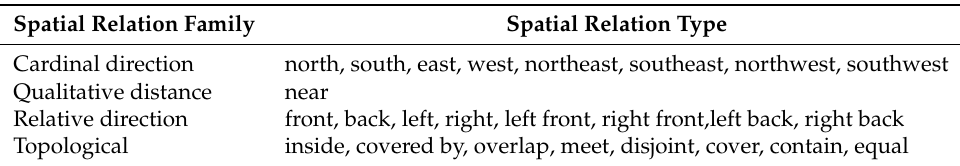
Table 1. Formal binary spatial relations considered in this